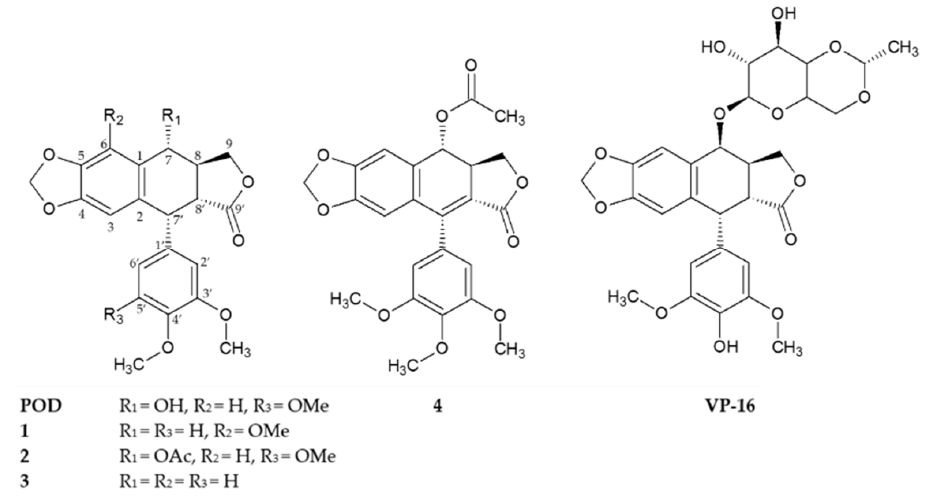
Figure 1. Chemical structures of compounds 1 – 4 isolated from the stem bark of Bursera fagaroides var. fagaroides , and the positives controls podophyllotoxin (POD) and etoposide (VP-16).